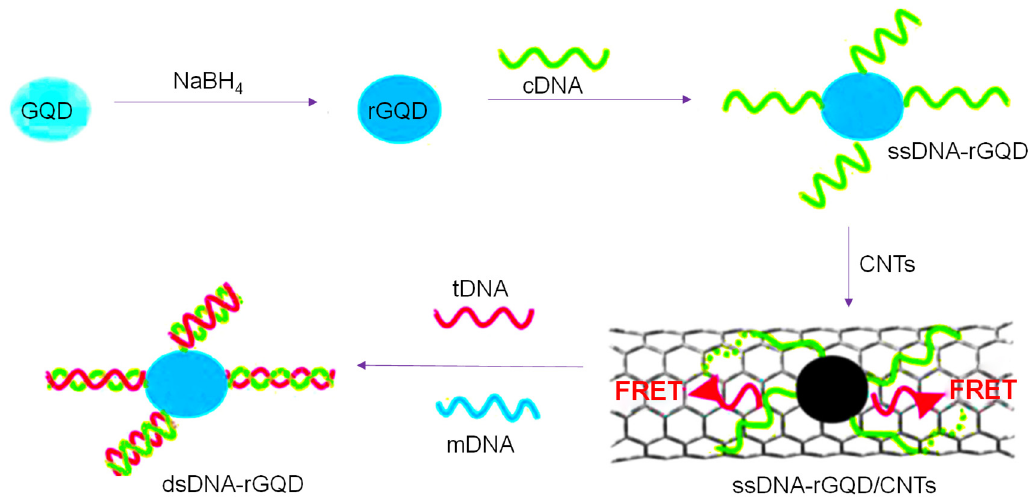
Figure 13. DNA detection strategy of GQD-based fluorescence resonance energy transfer (FRET) nanosensor [215].